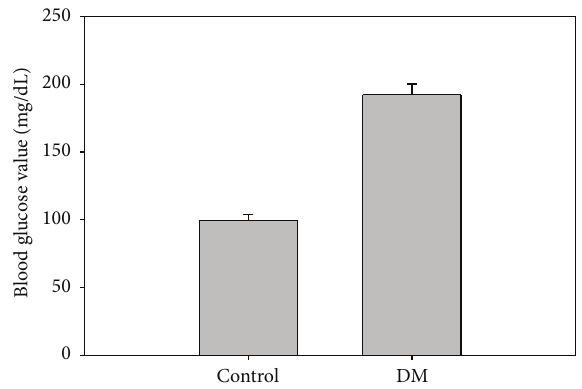
Figure 1: Determination of fasting blood glucose (FBG) in mice. FBG was measured in control and HFD administered DM mice for 6